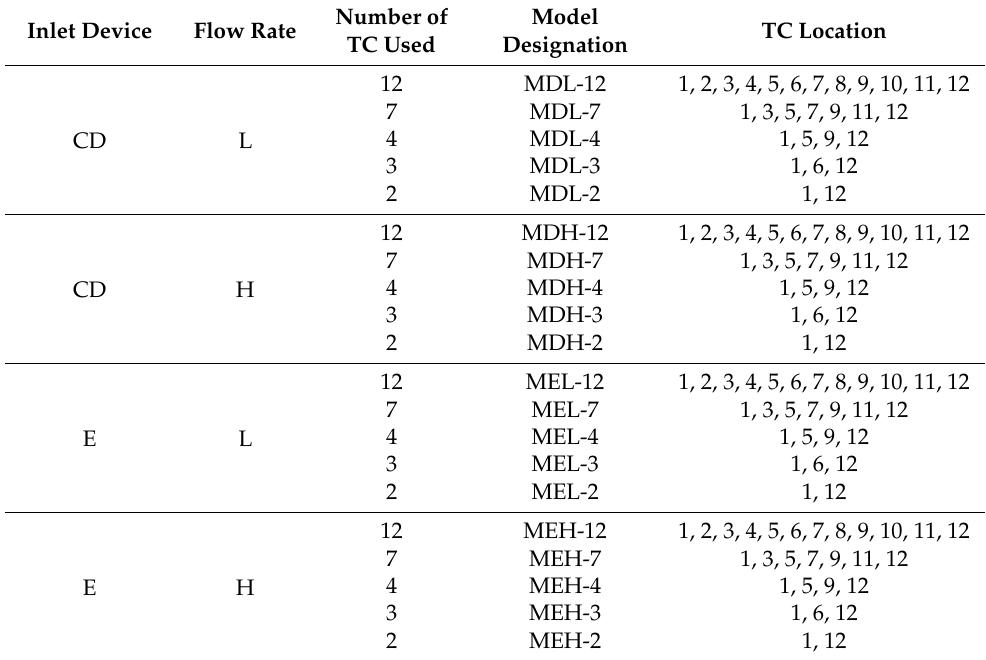
Table 2. Models performed to analyze the sensitivity of the VTC method to the number of TC used. Inlet